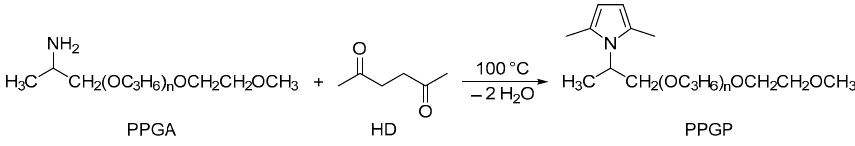
Figure 1. Synthesis of O -(2-(2,5-dimethyl-1 H -pyrrol-1-yl) propyl)- O ′ -(2-methoxyethyl)polypropylene glycol (Pyrrole polypropylene glycol, PPGP) . glycol (Pyrrole polypropylene glycol, PPGP).